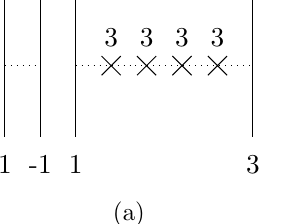
) is trivial [42]. (2 ; 2)